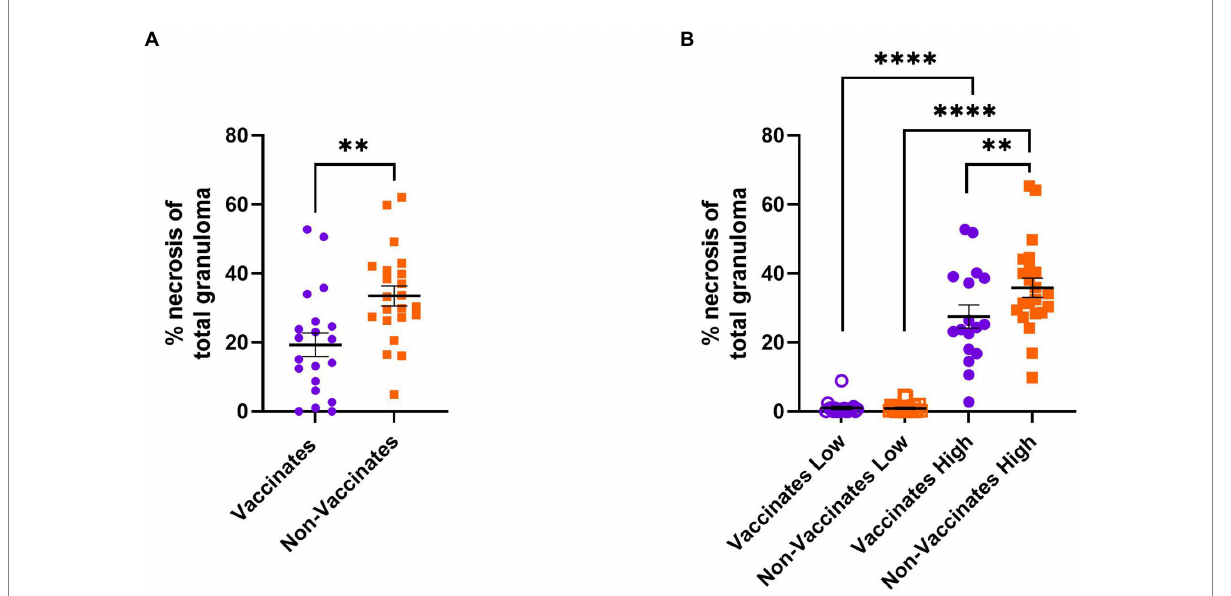
FIGURE 4 Percentage of granuloma area comprised of necrosis in BCG-vaccinated and non-vaccinated cattle infected with M. bovis. Values are broken down by vaccination group (A) and by vaccination group and grade (B) . Each dot represents one animal and its mediastinal and tracheobronchial lymph nodes. Values are presented as means ± SEM. (** = p value 0.0029 for A, ** = p value 0.0080 for B, **** = p value